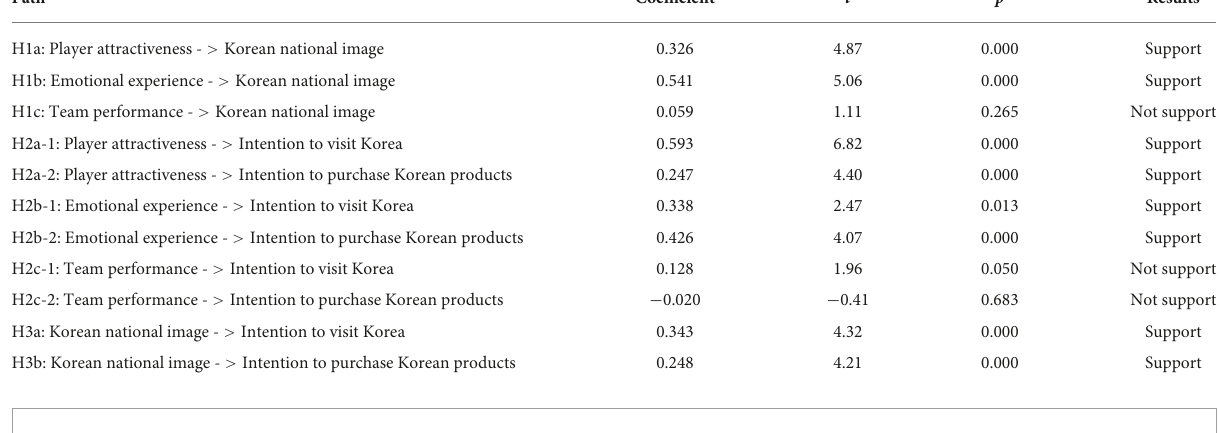
TABLE 4 Results of structural equation modeling.